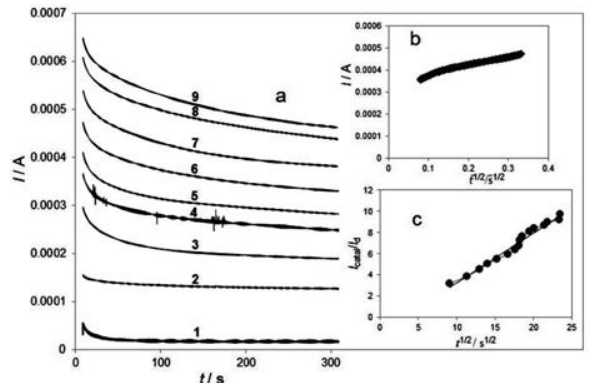
Figure 7. (a) Chronoamperograms of Ni-Cu electrode in 1 M NaOH solution with different concentration of ethanol: (1) blank, (2) 0.1, (3) 0.2, (4) 0.3, (5) 0.4, (6) 0.5, (7) 0.6, (8) 0.7 and (9) 0.8 M at potential step of 500 mV. (b) Dependency of transient current on t – 1/2 . (c) Dependence of I catal /I d vs. t 1/2 derived from the data of chronoamperograms.